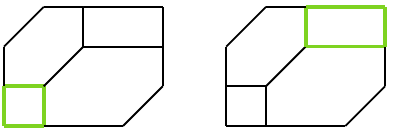
Figure 7 . Each cell is a Minkowski sum of sub-supports: the case (c), left and (d),